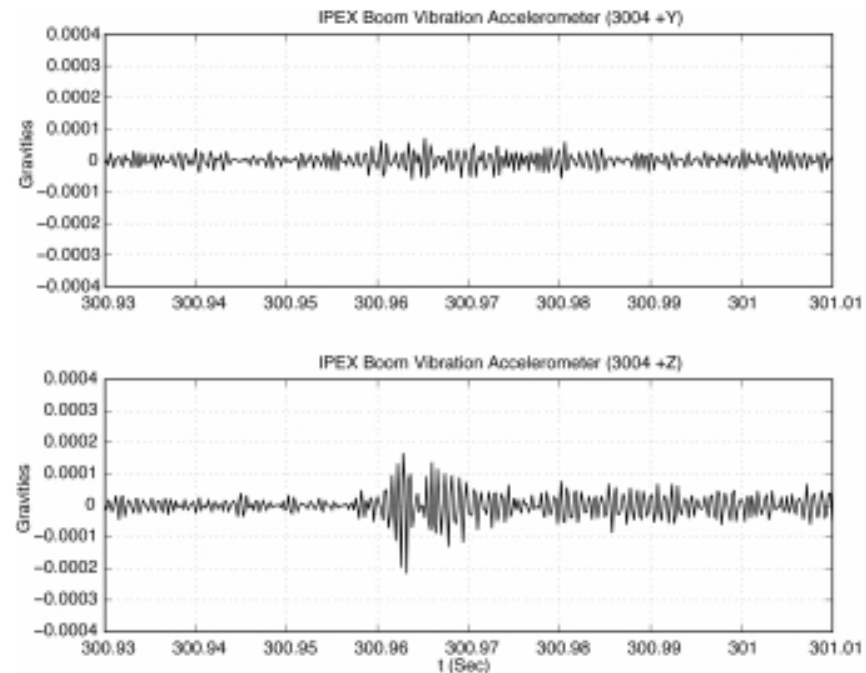
Fig. A7. Event 2 Node